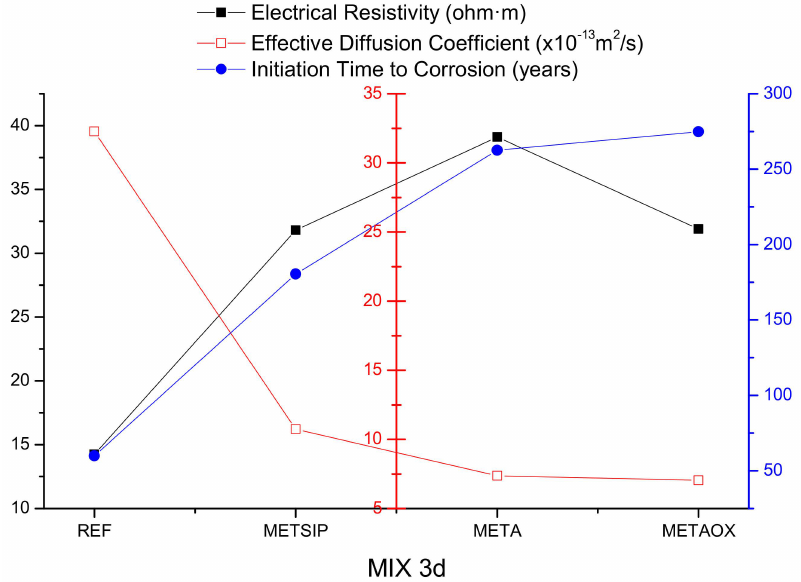
Figure 15. Electrical resistivity, e ff ective di ff usion coe ffi cient, and corrosion initiation time for mixes with three days of curing